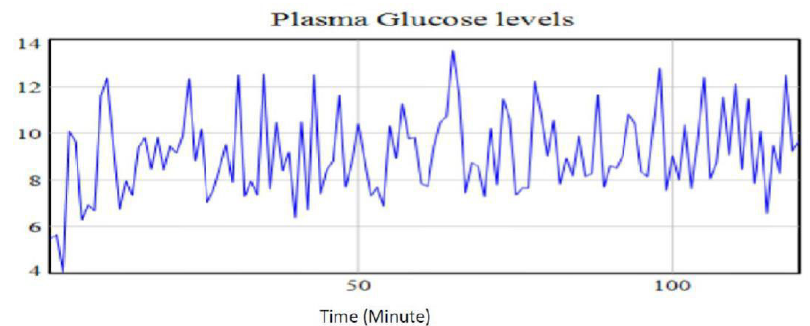
Figure 9. Plasma glucose levels using identified parameters for the extended Bergman Minimal Model for a type II diabetic patient with a 33.33% reduction in stress levels.